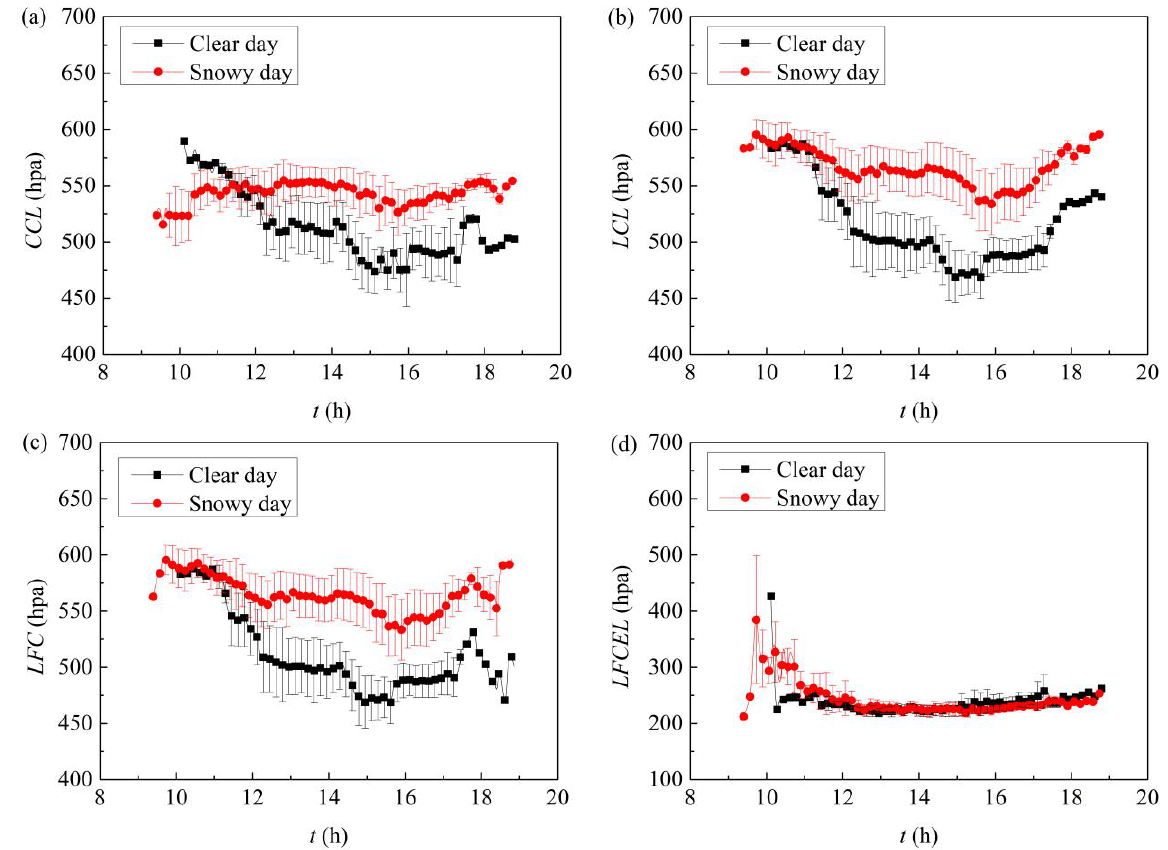
Figure 6. Statistical characteristics of parcel heights (from 8:00 to 20:00 monsoon seasons) under different weather conditions. ( a ) CCL , ( b ) LCL , ( c ) LFC , ( d ) LFCEL . The t (h) is expressed in UTC+8.